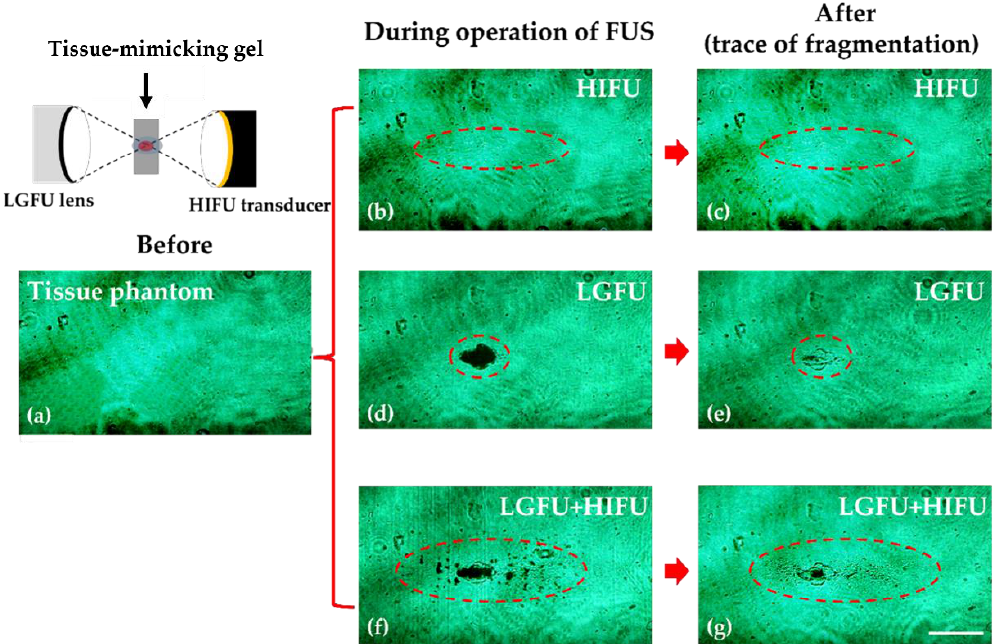
Figure 10. Shadowgraphy images of tissue phantom that was fragmentated by an LGFU-HIFU face-to-face ( θ = 180 ◦ ) configuration. ( a ) Agarose gel tissue phantom before applying LGFU and/or HIFU. ( b ) Real-time FUS operation with only HIFU and ( c ) the traces of fragmentation after only HIFU operation. ( d ) Real-time cavitation in tissue phantom with only LGFU operation and ( e ) the fragmentation traces after LGFU operation. ( f ) Cavitation in tissue phantom with LGFU and HIFU in real-time and ( g ) the fragmentation traces after LGFU and HIFU operation. When operating both the LGFU and HIFU at the same time, cavitation was significantly more intense than operating only the LGFU or HIFU. The lateral spot dimensions of LGFU and LGFU+HIFU were 236 and 394 µm, respectively. The axial spot dimensions of LGFU and LGFU+HIFU were 338 and 1302 µm, respectively. (Scale bar = 500 µm).